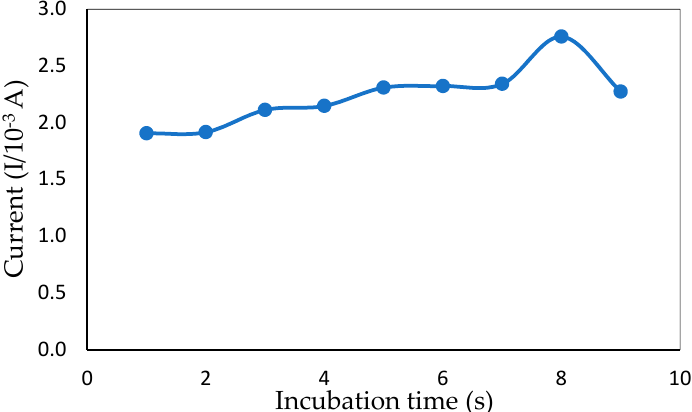
Figure 7. Peak current obtained from CV measurement showing the effect of different incubation times in the presence of 1 mM MB and 6 ppm of mercury (50 mM Tris-HCl buffer, pH 7.0).